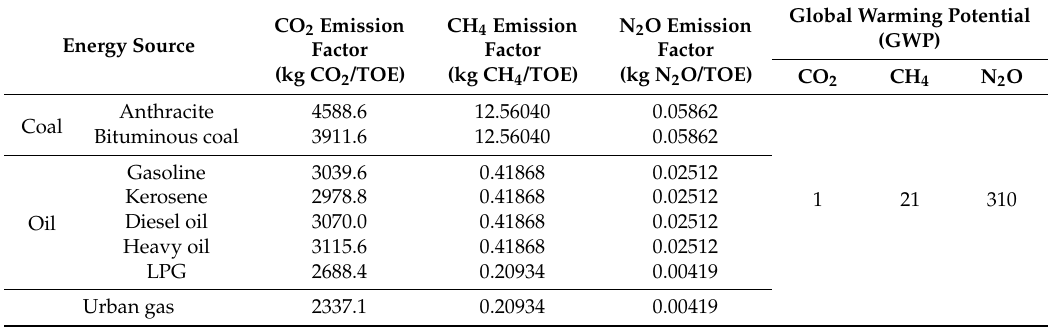
Table 3. Database of by energy source emission coefficient.